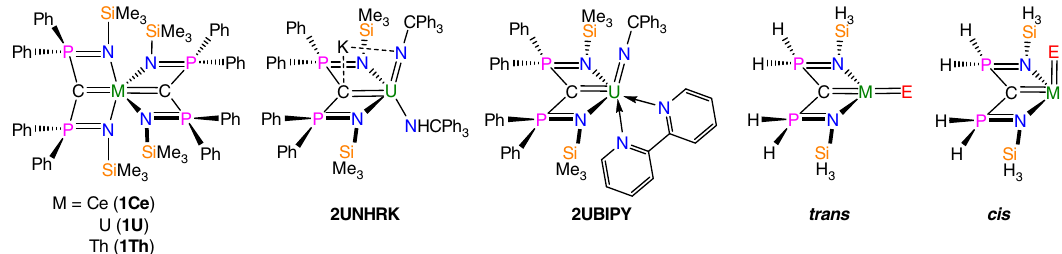
Fig. 1 Carbene complexes. Previously reported work 63,64 and trans and cis models studied in